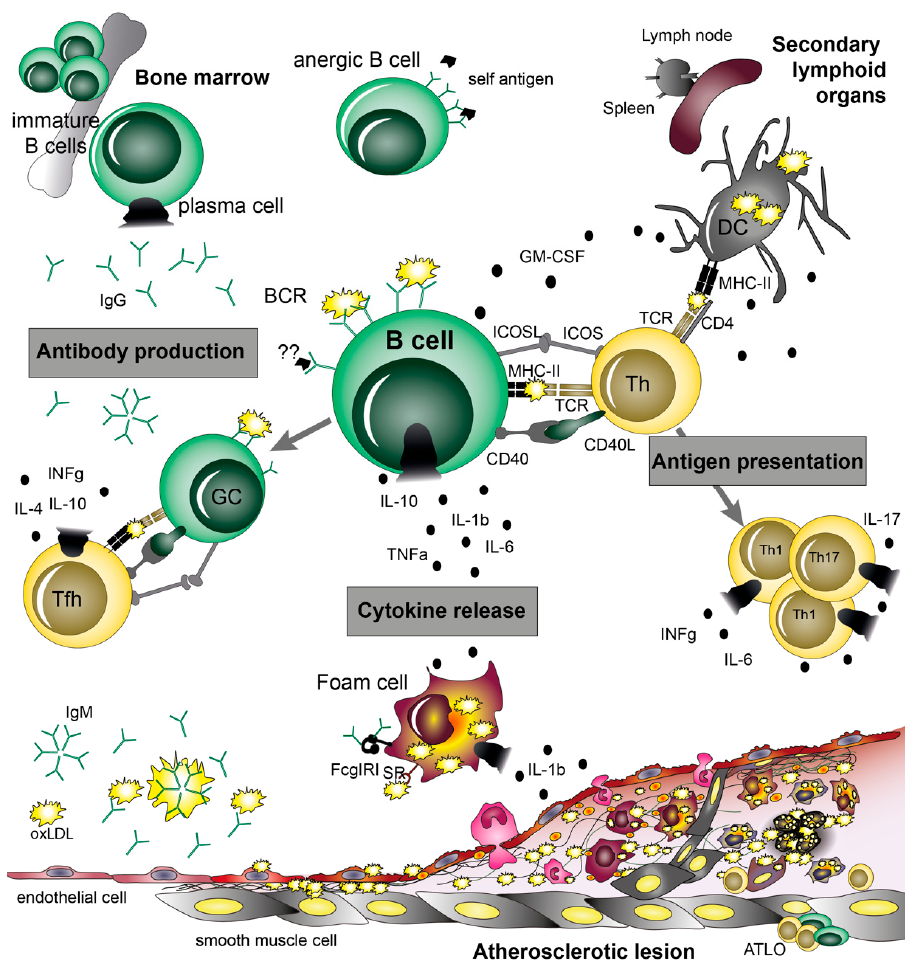
Figure 3. B cell functions in atherosclerosis. B cells can play both atheroprotective and pro-atherogenic roles, which are mediated by their main effector functions: (i) antibody production, (ii) cytokine release, and (iii) antigen presentation/interaction with T cells, which are dependent on their subset and activation state. By detecting (self)antigens via their specific B cell receptors (BCRs), B cells become activated and differentiate into antibody-producing plasma cells. This process is supported by the interaction of germinal center (GC) B cells and T follicular helper (Tfh) cells and results in the release of immunoglobulins (Ig). Ig can activate various cell types (e.g., macrophages) by binding to their respective Fc receptors (FcR), neutralize oxidized lipoproteins (oxLDL), and initiate complement activation and opsonization. Moreover, via release of cytokines such as TNF α , IL-6, IL-1 β , GM-CFS, and IL-10, B cells are able to affect their microenvironment in a pro- and anti-inflammatory way. In secondary lymphoid organs (spleen and lymph nodes) and arterial tertiary lymphoid tissues (ATLOs), interactions between B cells and Th cells take place via binding of co-stimulatory molecules (e.g., ICOS/ICOSL, CD40-CD40L) as well as antigen presentation of B cells via